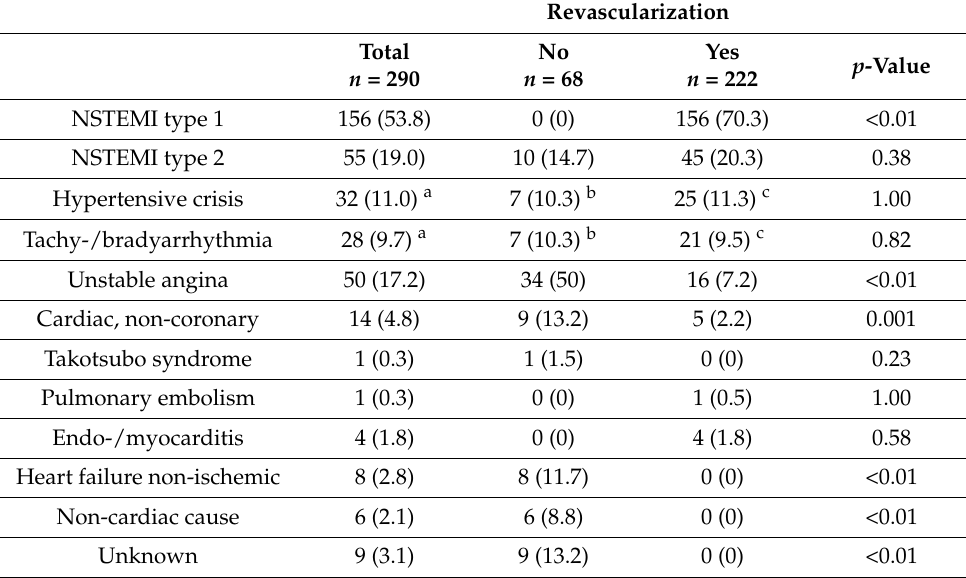
Table 1. Distribution of the adjudicated final diagnosis in patients with severe